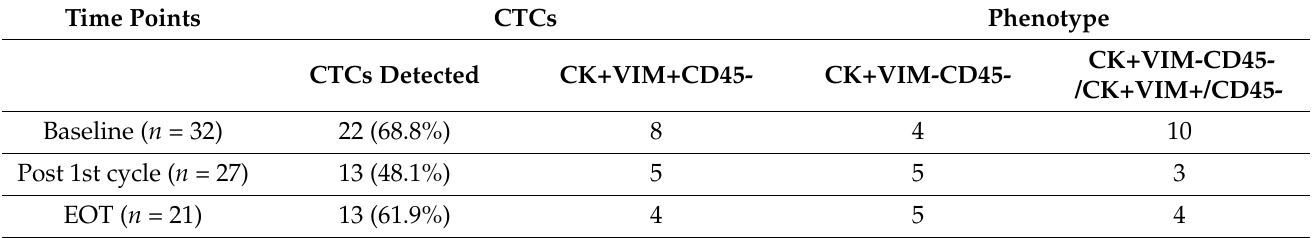
Table 2. CTCs and phenotype status at baseline, after Cycle 1, and at the EOT.